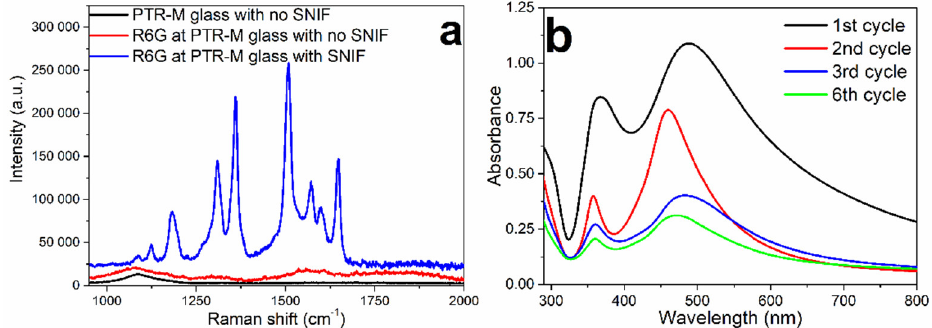
Figure 7. Raman spectra of PTR-M glass sample and R6G measured at ion-exchanged and heat- treated at 350 °C for 3 h ( a ). Absorbance spectra of PTR-M glass with SNIF after several cycles of the heat treatment at 500 °C for 15 min and removing the film before the following heat treatment at the same parameters ( b ).